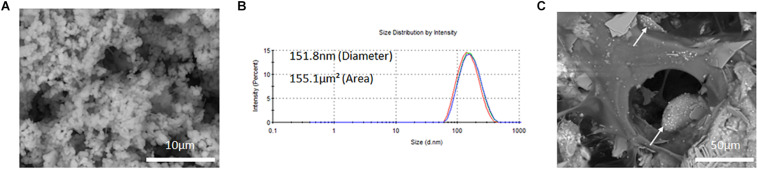
(A) SEM image of free PLGA-DOXO NPs. Scale bar represents 10 μm. (B) Zetasizer DLS readings of PLGA-DOXO NPs suspended in DI water. (C) SEM image of PLGA-DOXO NPs loaded bone cement (40/60 composition) (visible as white spheres). Scale bar represents 50 μm.